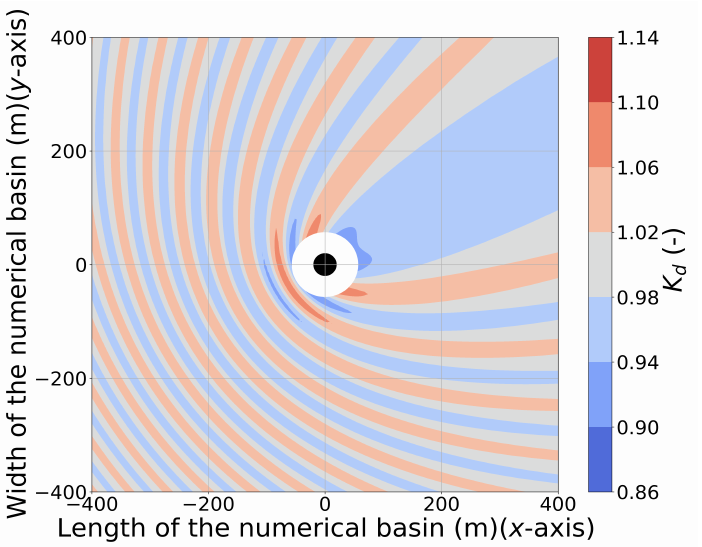
Figure 6. K d disturbance coefficient results for a single HCWEC interacting with a regular wave with H = 2.0 m, T = 8.0 s and θ = 30 ◦ . The coupling region is filled using a white solid circle which includes the WEC (indicated by a black solid circle). Incident waves are generated from the left to the right.